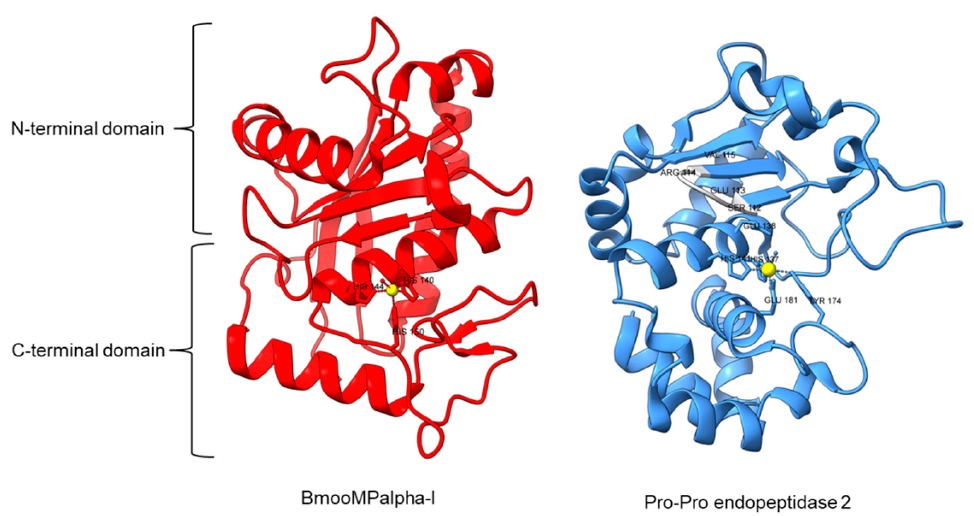
Figure 5. Crystal structures of MEROPS metallopeptidase M12.338 BmooMPalpha-I (left, PDB ID: 3GBO) and M34.003 Pro-Pro endopeptidase 2 (right, PDB ID: 6FPC) with substrate loop (S-loop) SERV in light gray. The zinc ions are shown as yellow spheres.